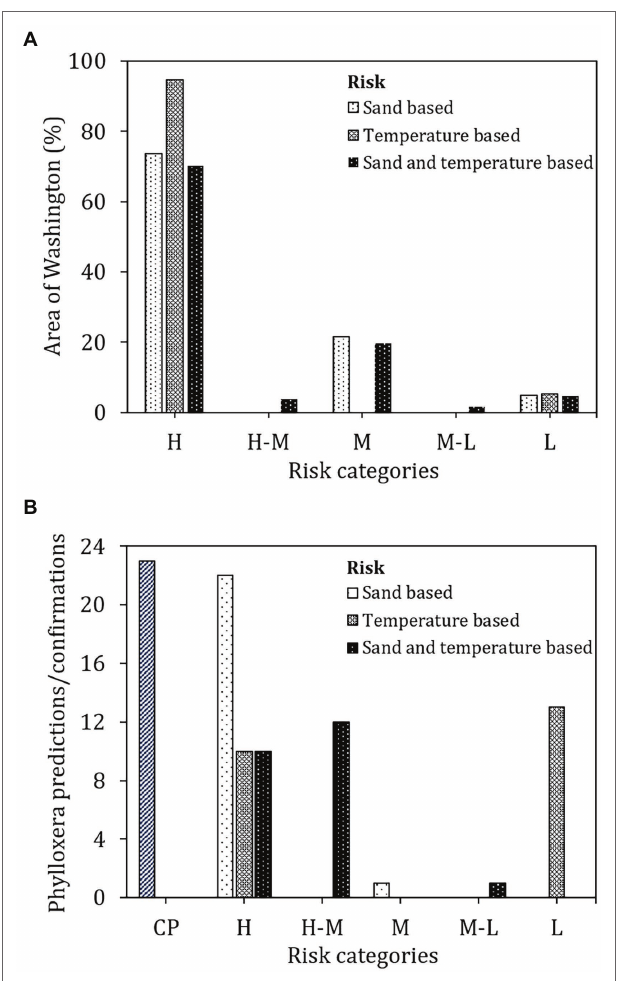
FIGURE 5 | (A) Area under predicted risk classes and (B) validation with confirmed positive sites in Washington. CP, confirmed positives; H, high; H-M, high-moderate; M, moderate; M-L, moderate-low; and L,